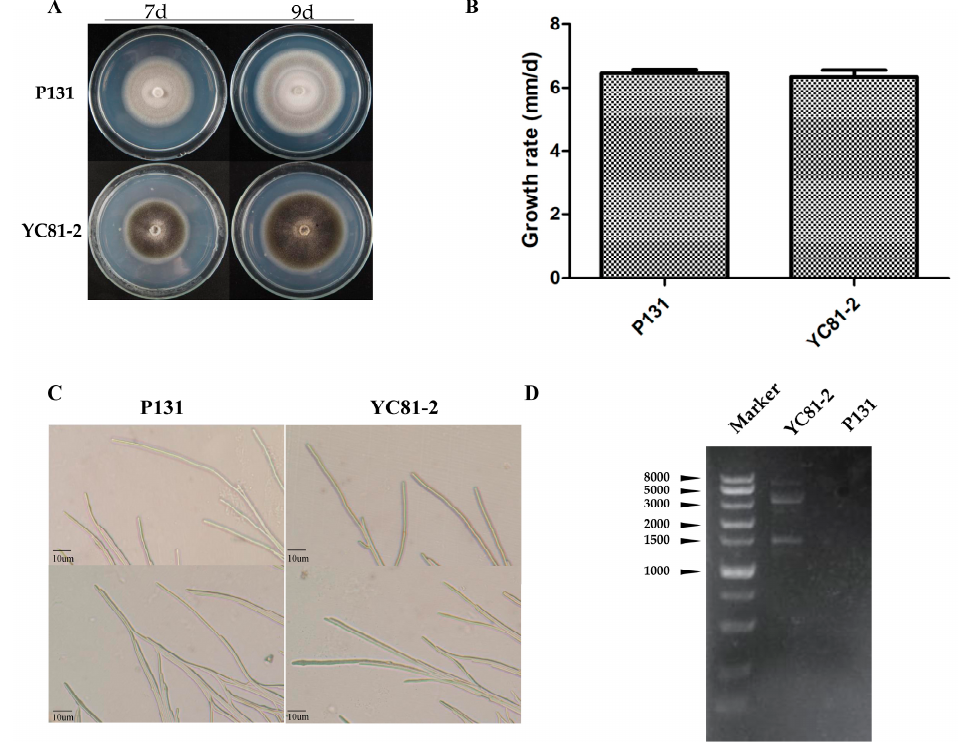
Figure 1. Morphological characteristics and dsRNA content of strains YC81-2 and P131. ( A )